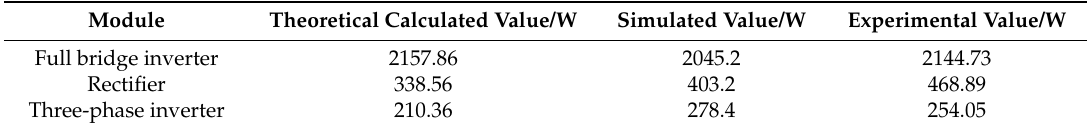
Table 4. Loss comparison of simulation, theory and experiment.